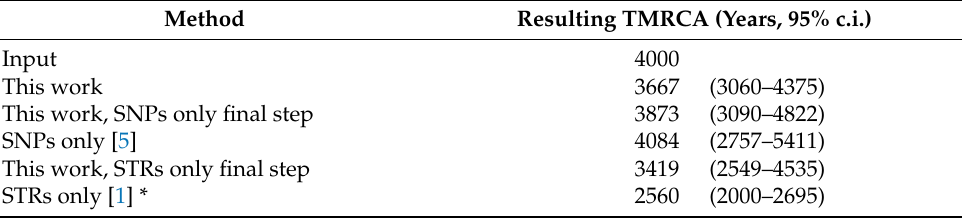
Table 4. Results for the MRCA in Example